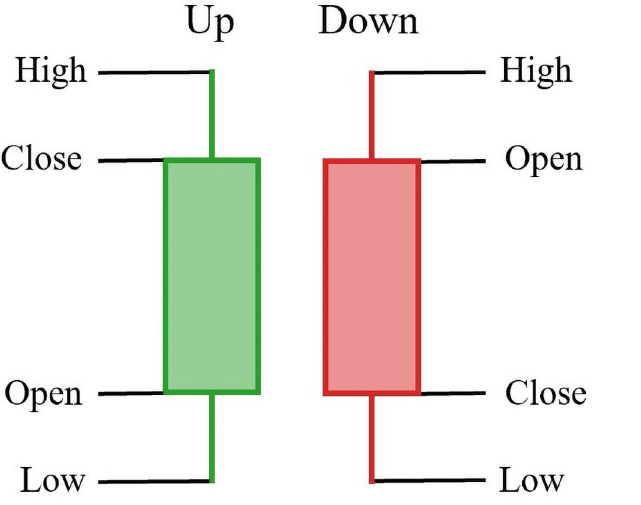
Fig 2. The basics of